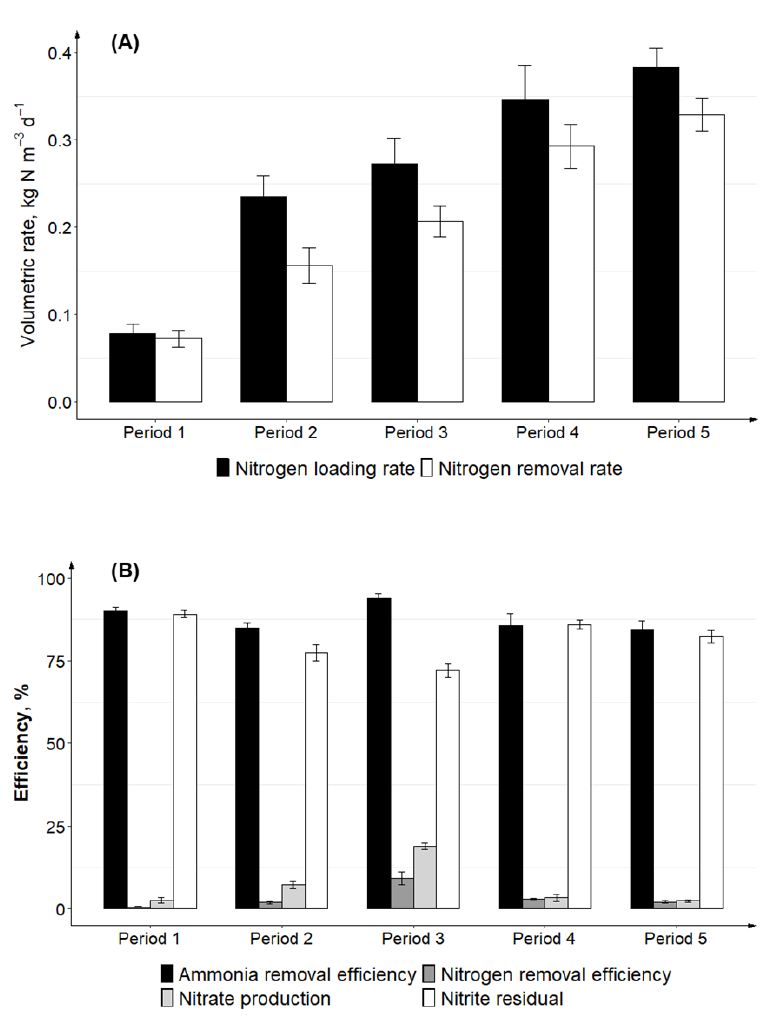
Figure 2. ( A ) Nitrogen loading and removal rates ( B ) and efficiencies with ammonia removal efficiency, nitrogen removal efficiency, nitrate production, and nitrite residual for Period 1 to Period 5 ( B ).